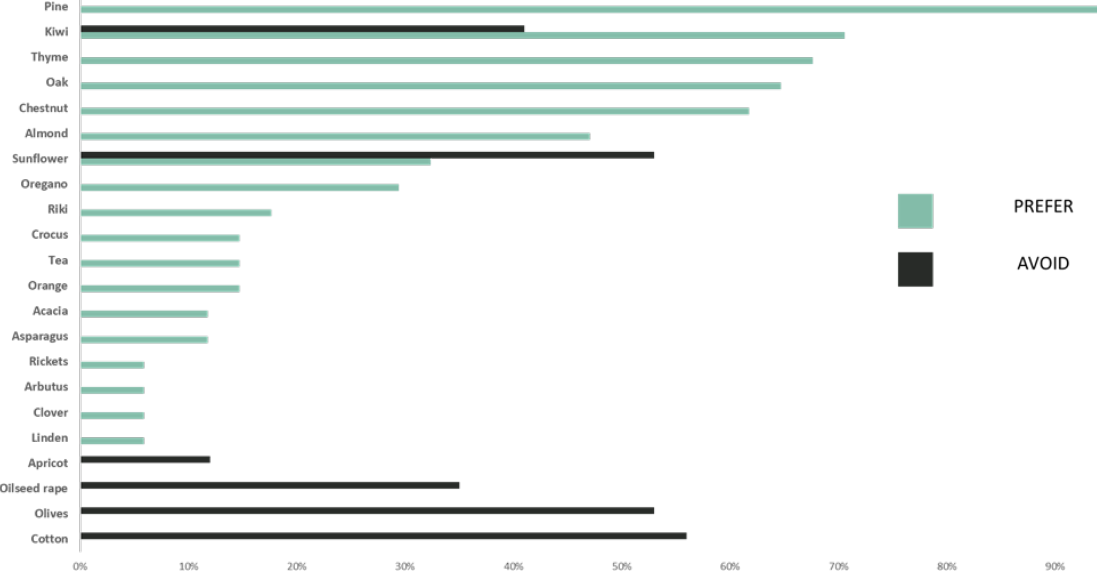
Figure 3. Summary of the main crops used (blue) and avoided (black) by beekeepers.